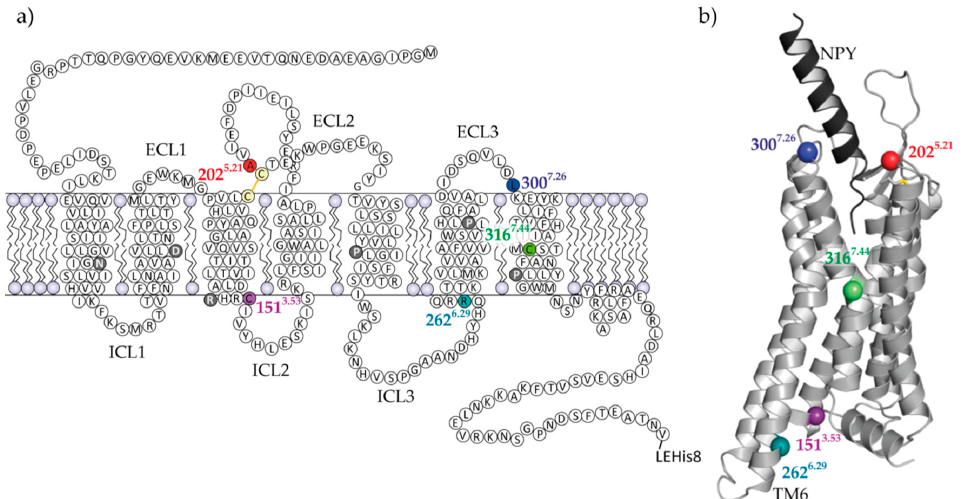
Figure 1. Sequence and structural organization of Y 2 R. The snake plot of the cysteine-deficient Y 2 R variants ( a ) and the structural model [36] of Y 2 R (light grey) in complex with the natural ligand NPY (black) ( b ), illustrate the location of the investigated sites. Mutagenesis sites for introducing cysteines and spin labeling are colored. The artificial C-terminal LEHis8-tag was introduced for purification purposes. The dark grey colored amino acids in the snake plot are highly conserved and constitute the basis for the nomenclature of the amino acids according to Ballesteros and Weinstein